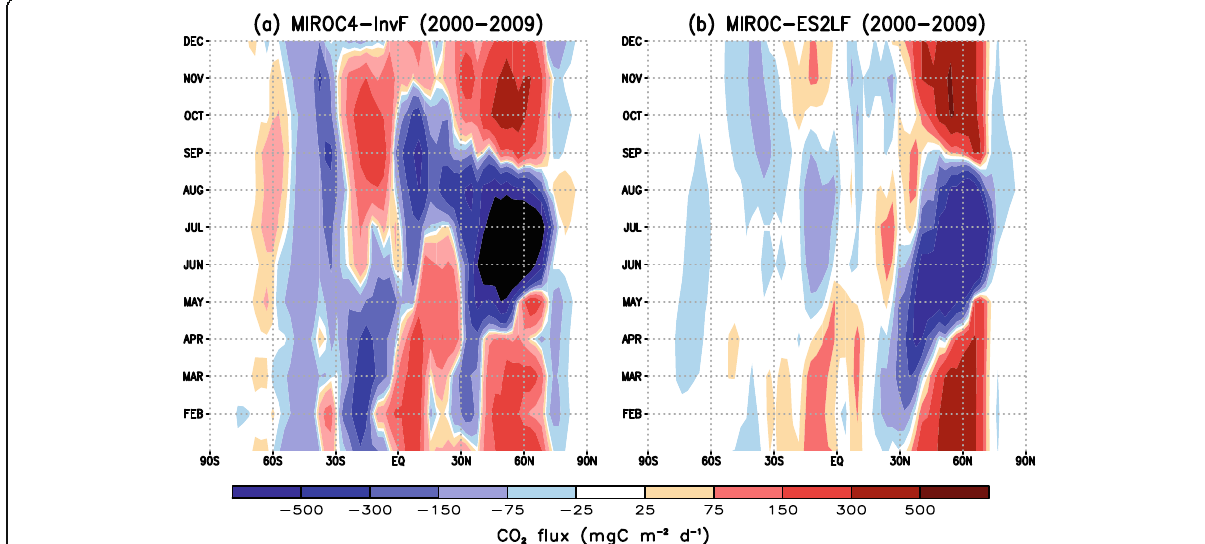
Fig. 3 Zonal mean meridional and seasonal variations in CO 2 fluxes as estimated by atmospheric inversion (MIROC4-Inv) and simulated by the earth system model